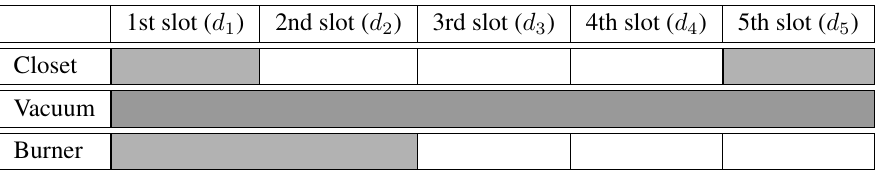
Table 1. The EST representation of participant’s input regarding